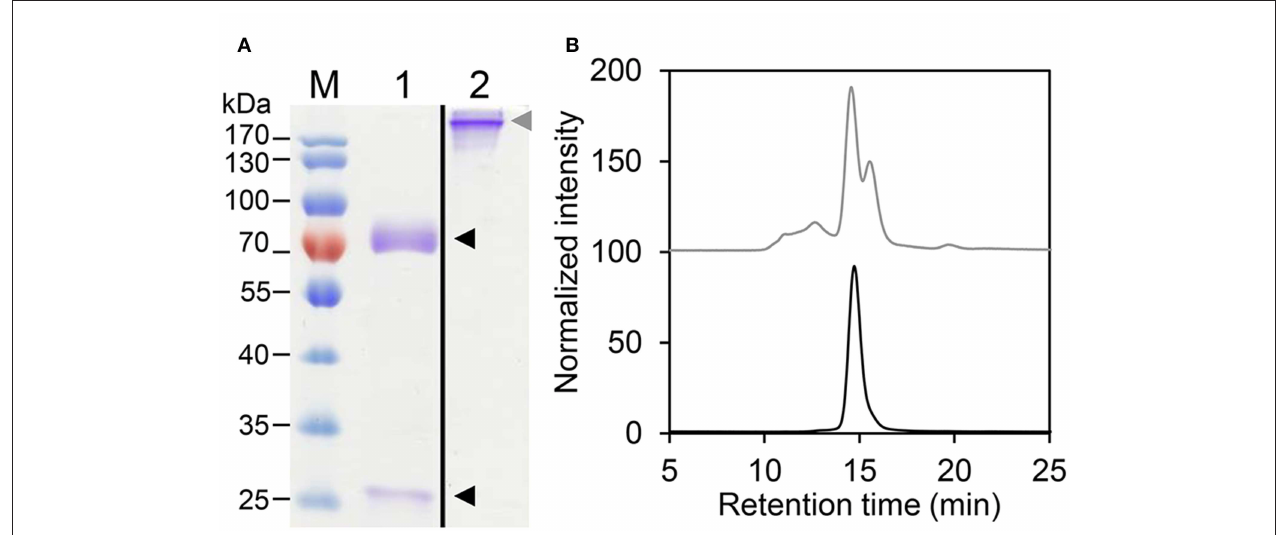
FIGURE 1 | Biochemical characterization of HER2-IgE. (A) Coomassie brilliant blue stained SDS-PAGE of purified plant-produced HER2-IgE (4 µ g). M, molecular weight marker; 1, reducing conditions; 2, non-reducing conditions. Black arrowheads: heavy and light chains; gray arrowhead: assembled HER2-IgE. Molecular weight shown in kilo Dalton (kDa). (B) Size Exclusion-HPLC measurements of HER2-IgE 1 XF before (gray) and after (black) preparative SEC.